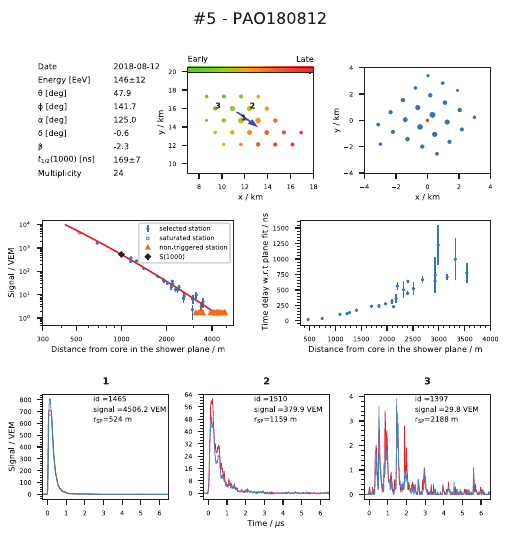
Figure 1. An event of the catalog, PAO180812 (#5). Top panel: the reconstructed features of the shower (left); the footprint at ground (middle) and in a plane perpendicular to the shower ar- rival direction (right). Middle panel: the lateral distribution func- tion (left) and the time delays with respect to a plane shower front (right). Bottom panel: FADC traces of three water-Cherenkov detectors (di ff erent lines correspond to the three calibrated pho- tomultipliers). Figure 2. Top : Footprint on the ground of the most energetic